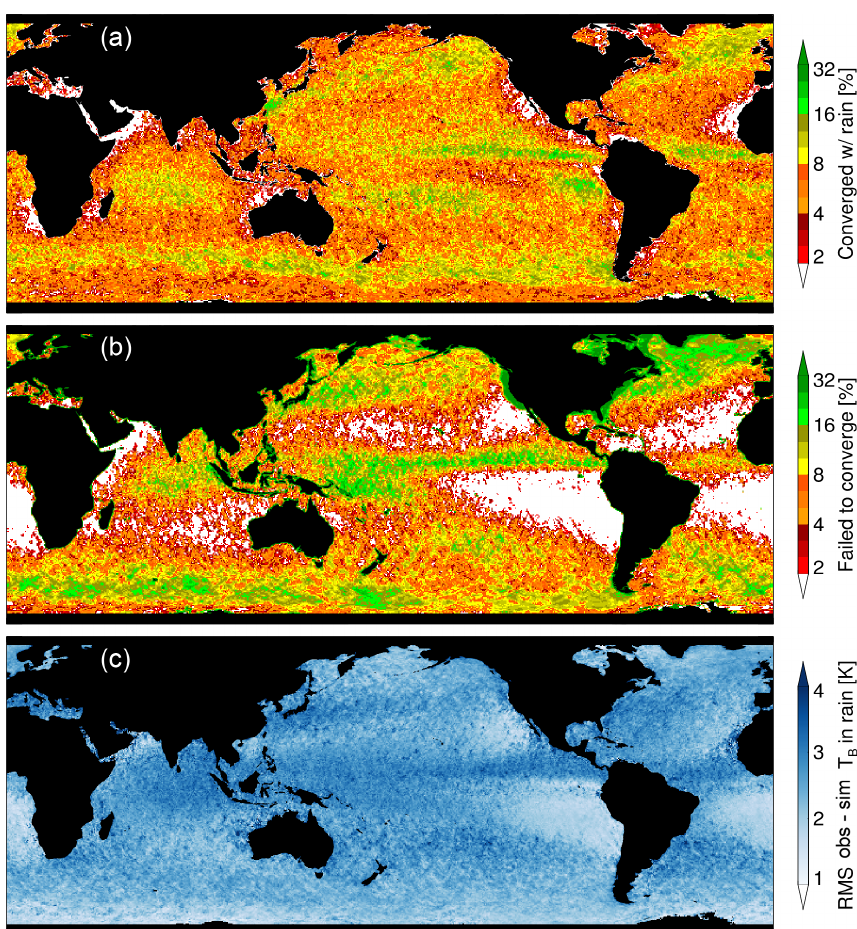
Figure 12. One year of GMI 1DVAR retrievals gridded at 0.5 ◦ resolution. The panels show: frequency of pixels with a non-zero rain rate (a) , frequency of non-convergent pixels (b) , and the average root mean squared (RMS) errors between observed and simulated T B over all 13 channels for raining retrievals only (c)